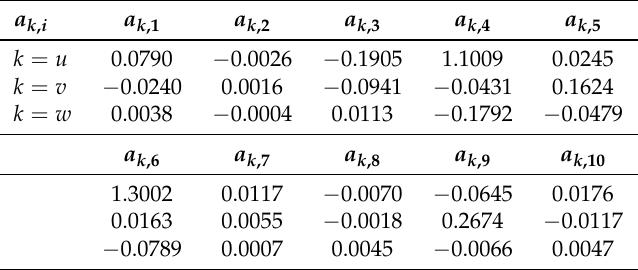
Table 4. F k ( x , y , z ) wake mean field regression results.